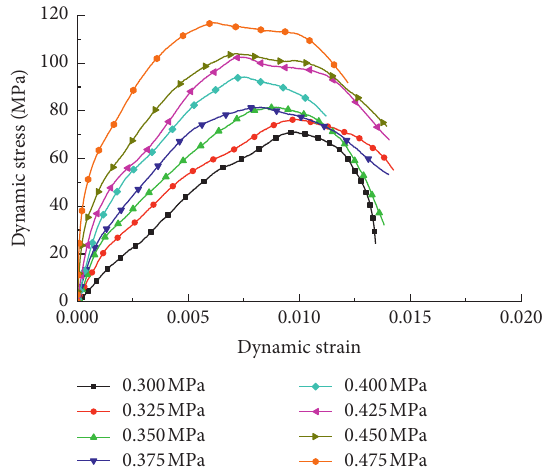
Figure 10: Dynamic stress-strain curve of